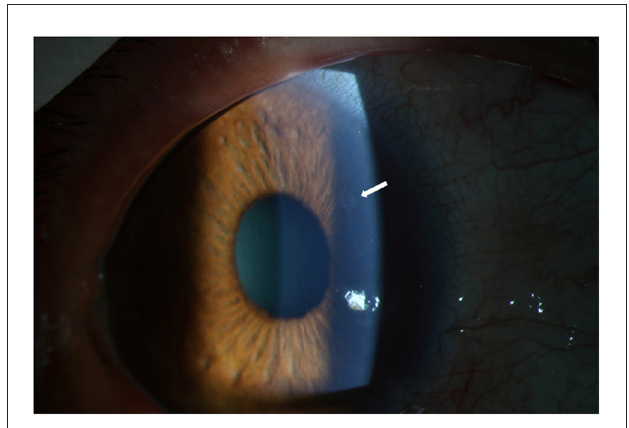
FIGURE2 Fresh KPs in the relapse following COVID-19 vaccination. Captured from the right eye of a 47-year-old male patient. Typical KPs (white arrow) appeared on the upper corneal endothelium at the third day after COVID-19 vaccination. KP, keratic precipitate.